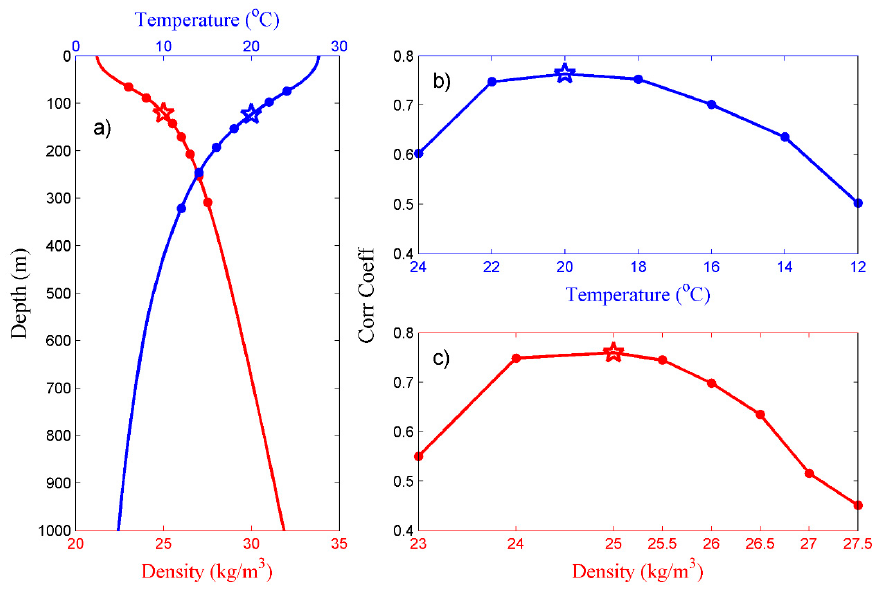
Figure 3. ( a ) The mean temperature (blue) and density (red) profile in the South China Sea derived from the World Ocean Atlas 2013. The correlation coefficient between the SLA and ULTA calculated by different ( b ) temperature and ( c ) density. The stars indicate where the maximum correlation coefficients appear.